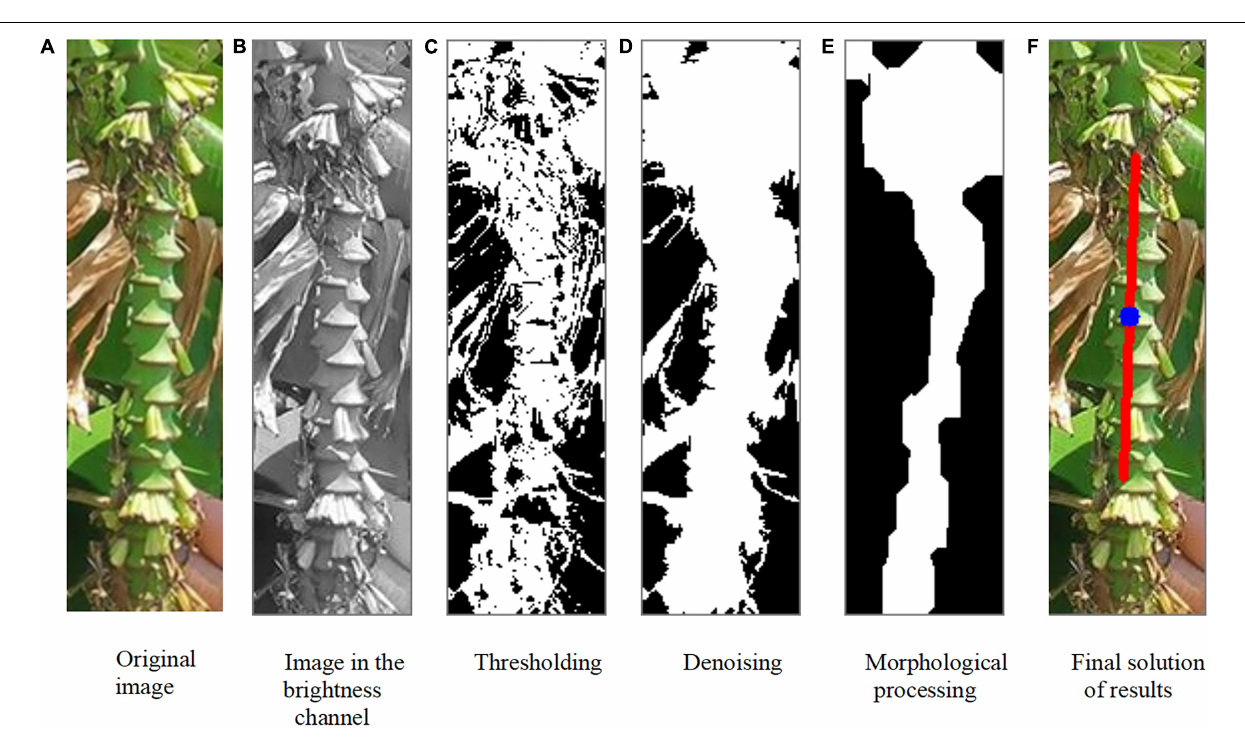
FIGURE 9 | Inflorescence axis extraction and growth direction calculation. (A) Original image. (B) Image in the brightness channel. (C) Threshholding. (D) Denoising. (E) Morphological processing. (F) Final solution of